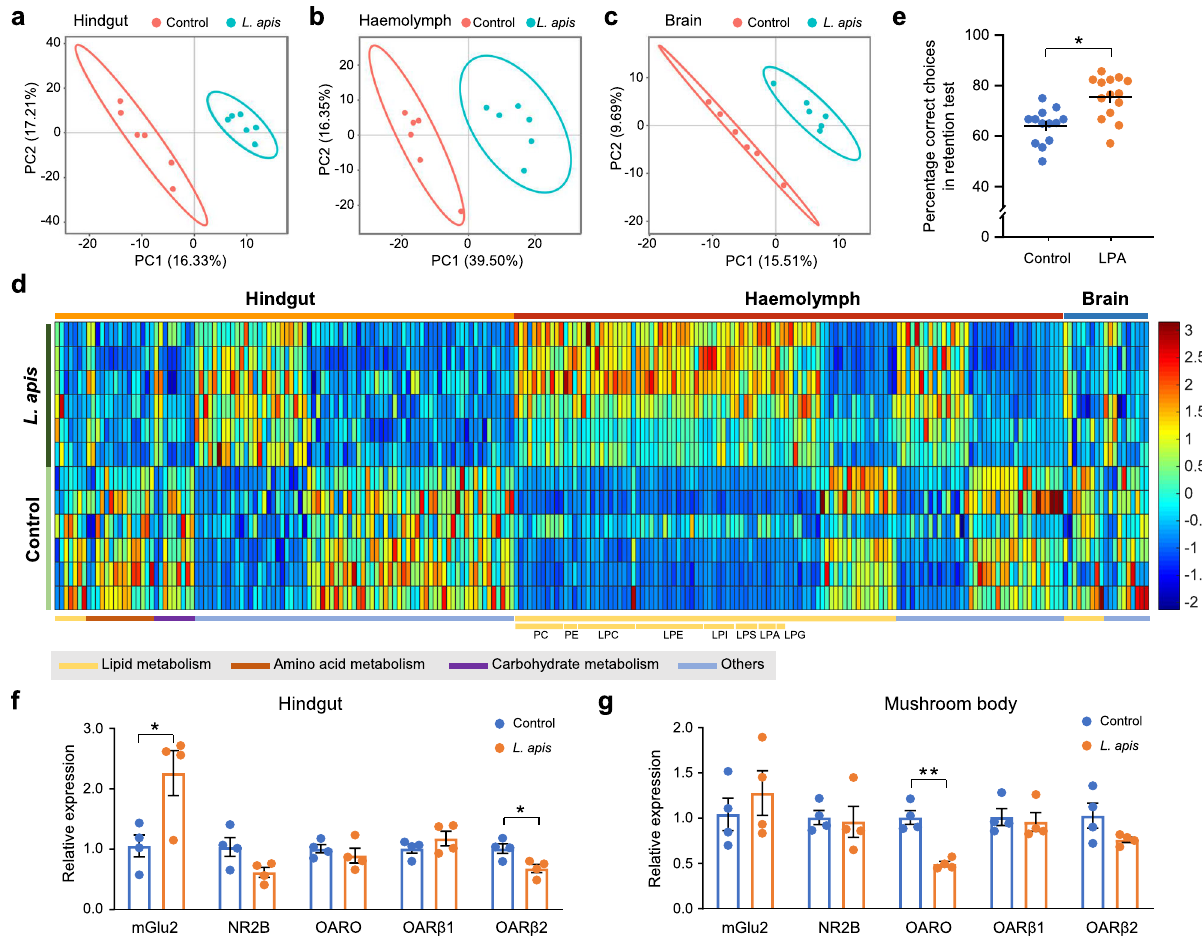
Fig. 3 L. apis supplementation affects host metabolites and neural receptor gene expressions in bees. a – c Metabolomic analyses of bumblebee hindgut ( a ), haemolymph ( b ) and brain ( c ) samples from control and L. apis- fed bees. Partial least-squares discrimination analysis (PLS-DA) showed that the metabolomic pro fi les of the hindgut, haemolymph and brain in L. apis -fed and control bees differed ( n = 6 for both groups). d Heatmap showing signi fi cantly altered metabolites in the bumblebee hindgut, haemolymph and brain. Colours indicate the normalised abundance of each metabolite. e The effect of one glycerophospholipid LPA (14:0) on long-term memory (GLMM, df = 24, p = 0.028; n = 13 for the Control group and n = 14 for the LPA group; Supplementary Table 3). f and g L. apis supplementation affects the gene expression of neural receptors in the host hindgut and brain mushroom body (two-sided Student ’ s t test: mGlu2 in the hindgut, t 6 = 2.9175, p = 0.027; OAR β 2 in the hindgut, t 6 = − 3.1301, p = 0.020; OARO in the mushroom body, t = − 6.3565, p = 7.110 × 10 − 4 ; n = 4 bees for both groups). Asterisks indicate signi fi cant differences (* p < 0.05, ** p < 0.01). Data are presented as 6 mean ± SEM. PC phosphatidylcholine, PE phosphatidylethanolamine, LPC lysophosphatidylcholine, LPE lysophosphatidylethanolamine, LPI lysophosphatidylinositol, LPS lysophosphatidylserine, LPA lysophosphatidic acid, LPG lysophosphatidylglycerol, mGlu2 metabotropic glutamate receptor 2, NR2B glutamate receptor ionotropic NMDA 2B, OARO octopamine receptor Oamb, OAR β 1 Octopamine receptor beta-1R, OAR β 2 Octopamine receptor beta-2R. Source data are provided as a Source Data fi